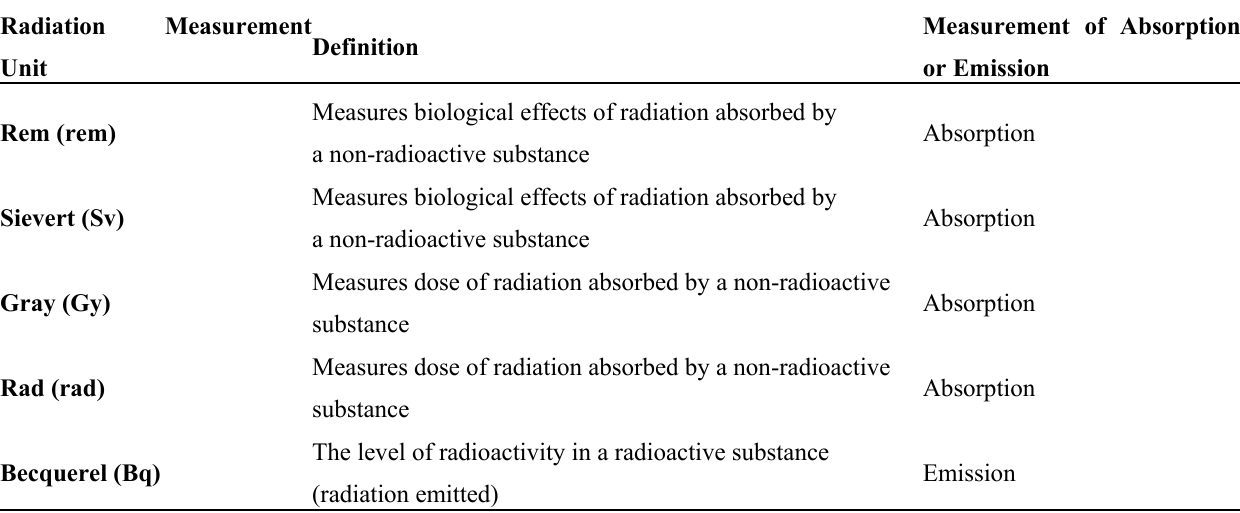
Table A4. Radiation measurement units defined.